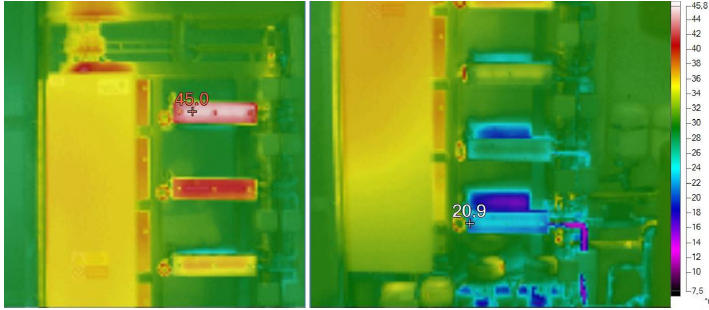
Figure 6. Technical issue—thermographic diagnostic.